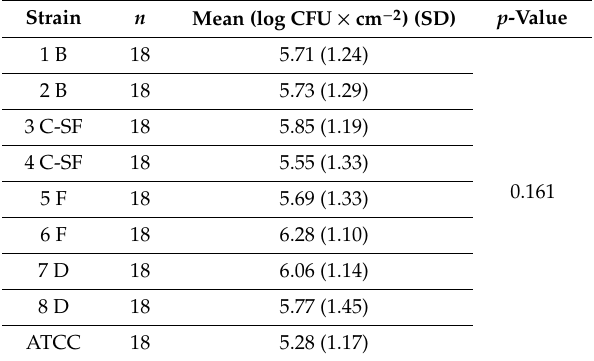
Table 1. Comparison of biofilm formation ability of L. monocytogenes strains for different strains.